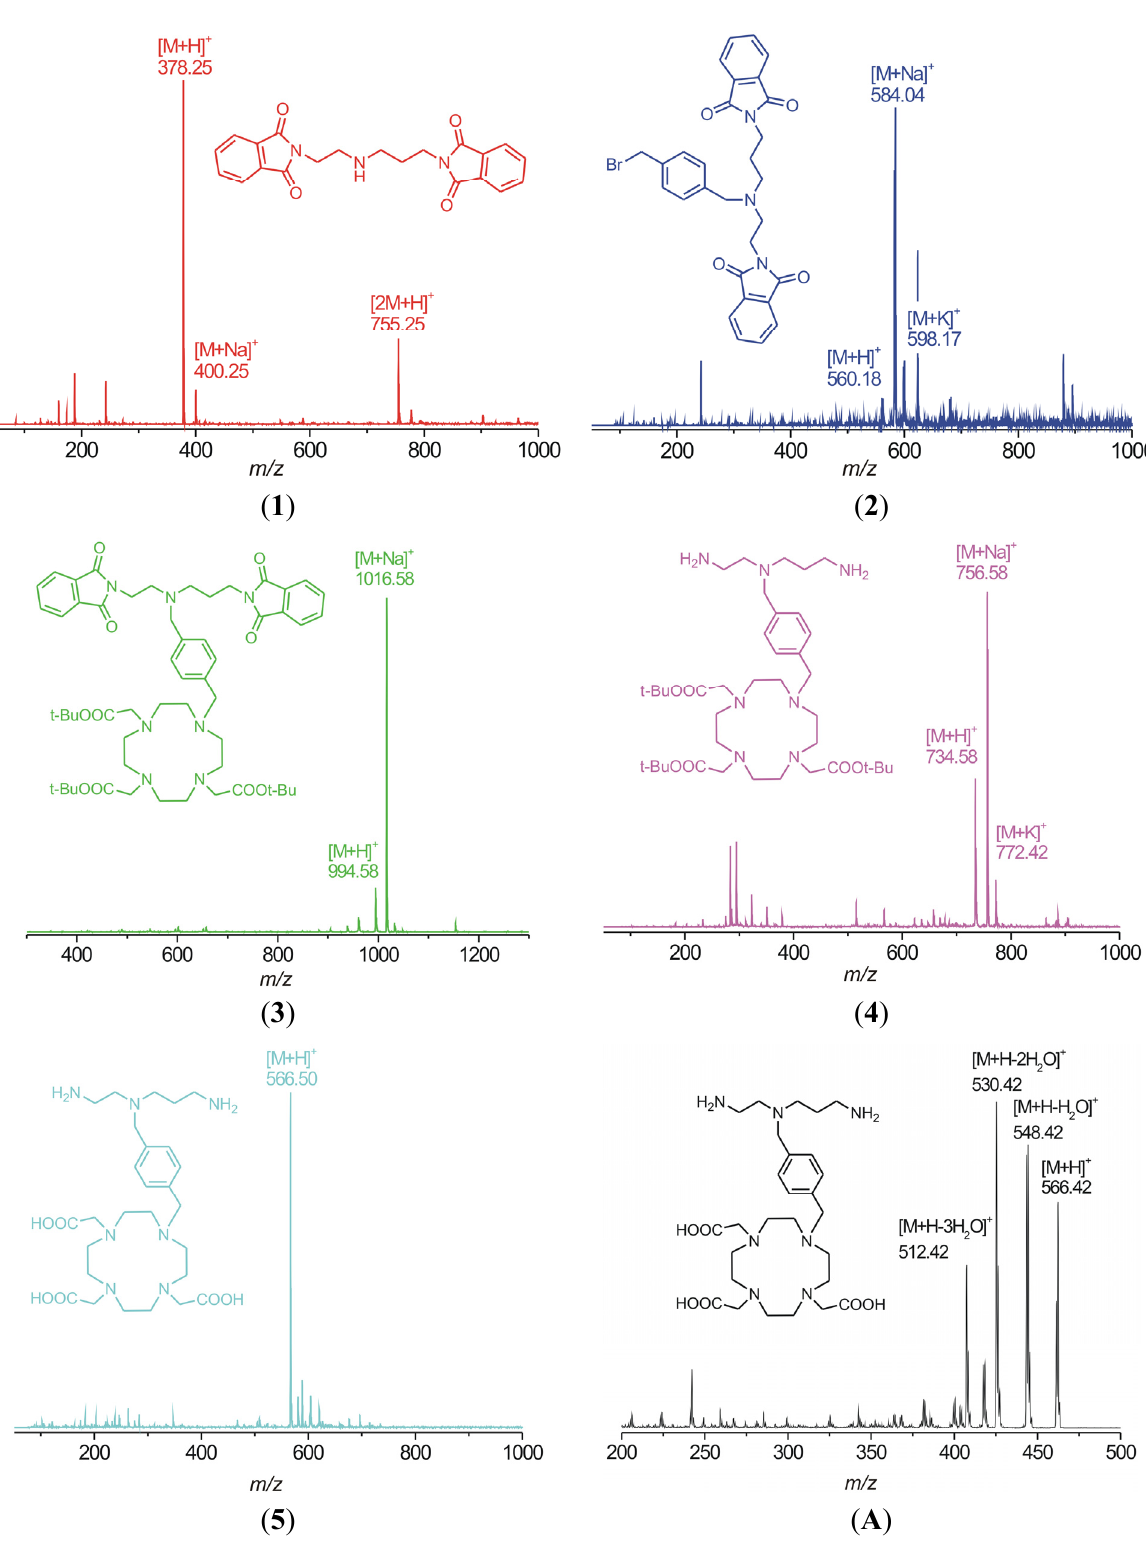
Figure 4. ESI mass spectra of intermediates 1 – 4 and the final product 5 showing the molecular peaks (adducts with H + , Na + or K + ) together with MS 2 pattern of the molecular ion m/z 566.50 ( A